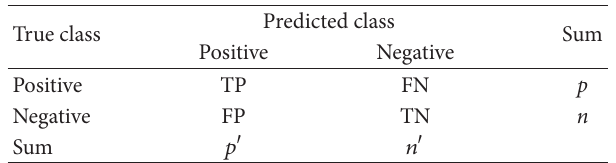
Table 7: 2 × 2 confusion